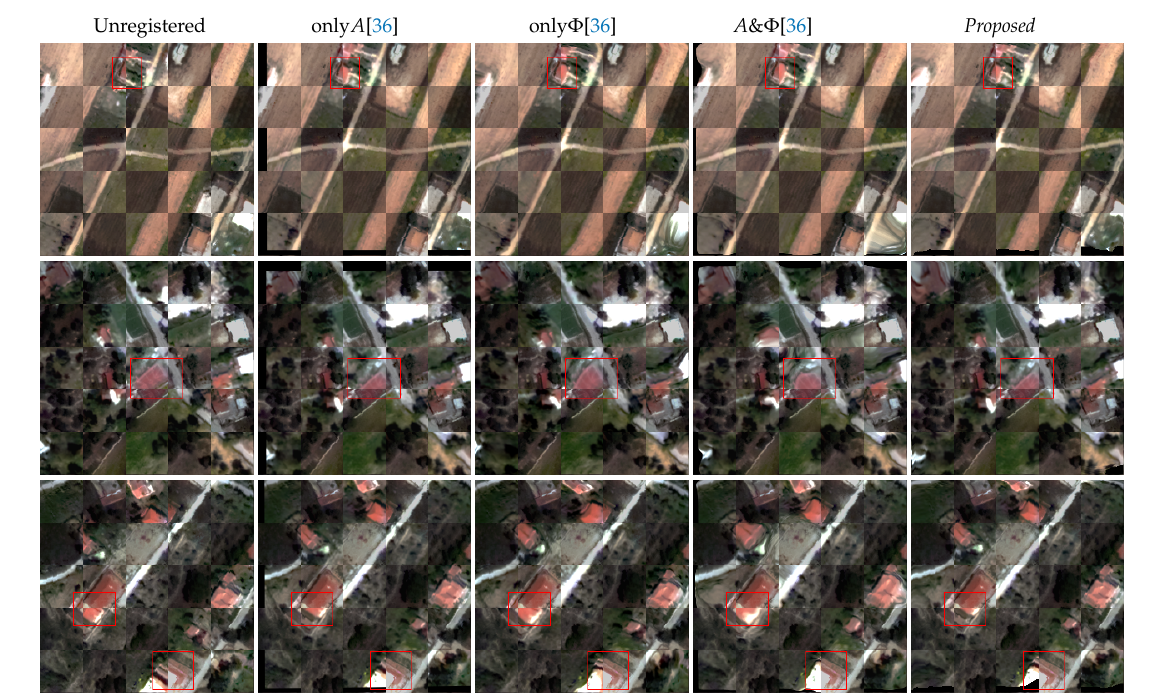
Figure 4. Qualitative evaluation on different pairs from the Attica VHR testing regions. Different approaches from [36] are compared i.e., from left to right: Unregistered raw data, results: only A , only Φ , A & Φ , Proposed .